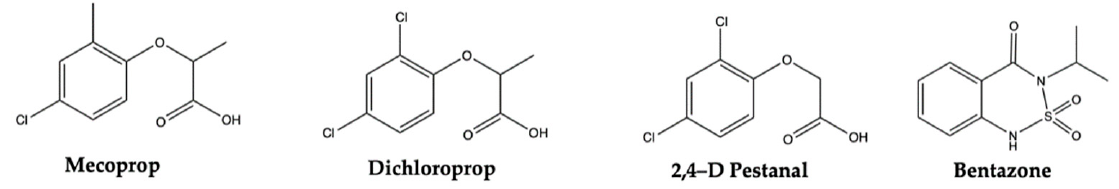
Figure 6. Molecular structure of interferents.